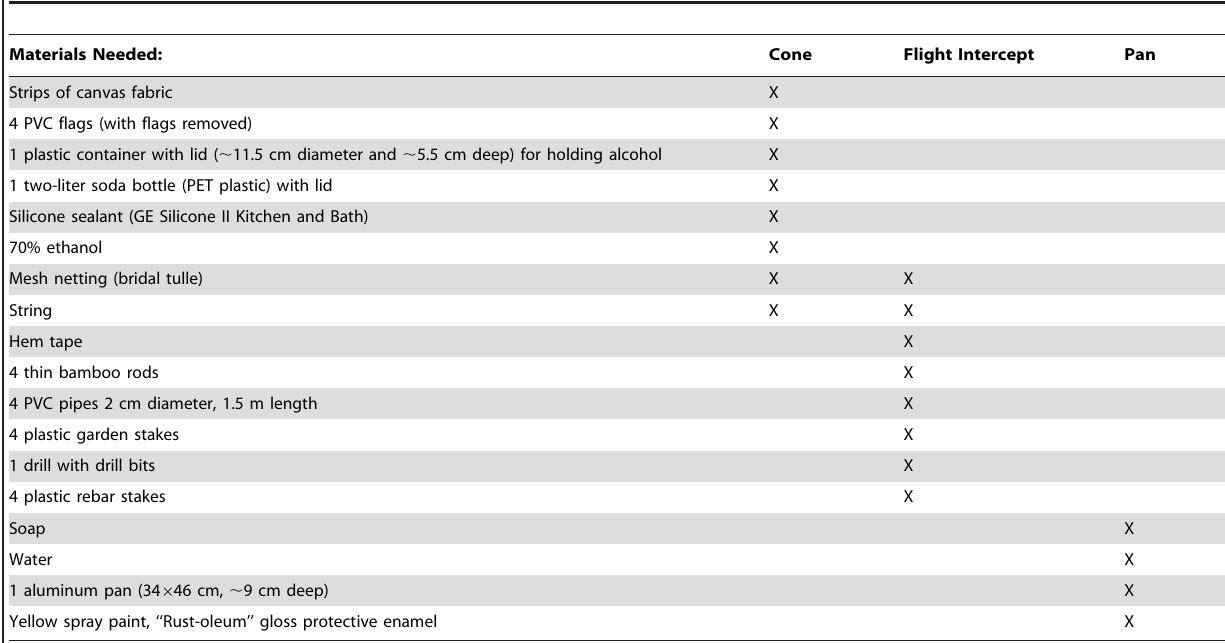
Table 1. Components required to build the three portions of the Composite Insect Trap.